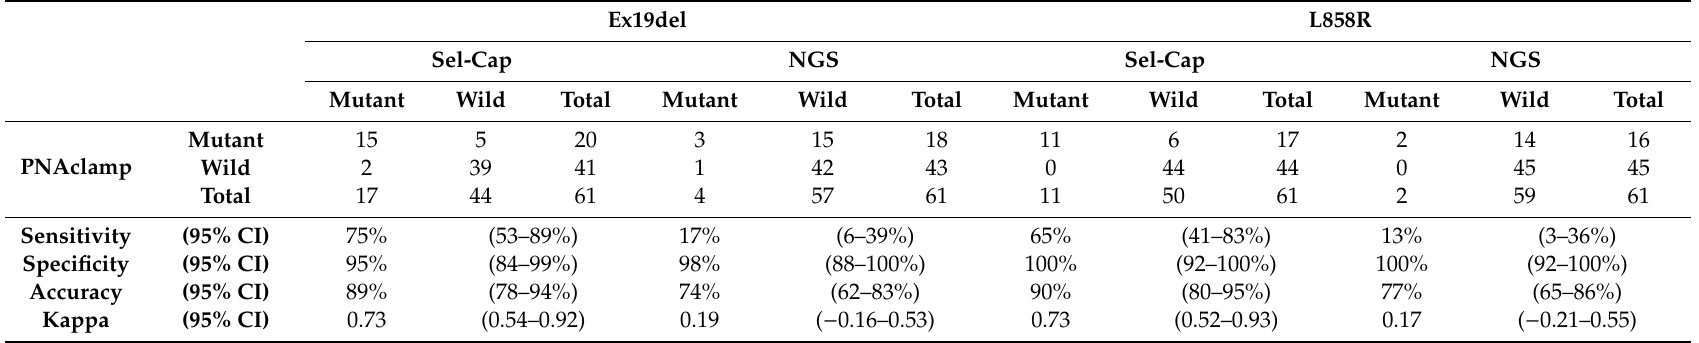
Table 1. Diagnostic performance of Sel-Cap and conventional NGS liquid biopsies for two EGFR activating mutations in NSCLC patients (n = 61), with paired PNAclamp tumor biopsy as the